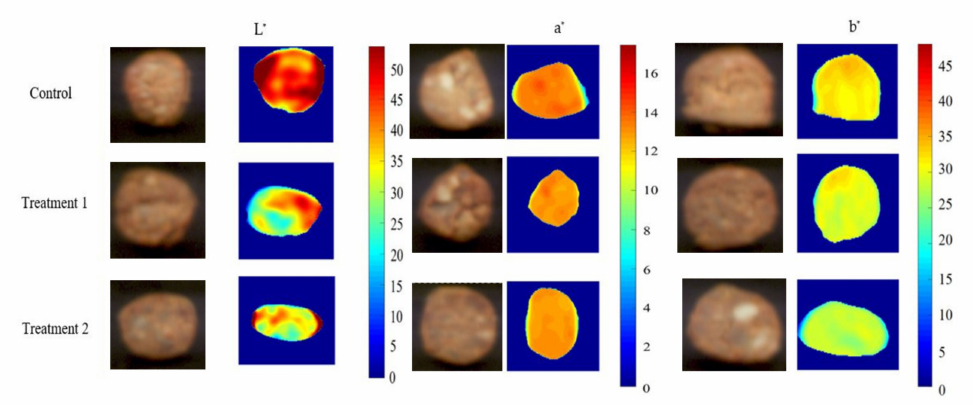
Figure 3. Original sausage images and a corresponding distribution map of lightness (L*), redness (a*), and yellowness (b*) changes of control casing sausages (up), and sausages stu ff ed in modified casings using treatment 1 (central) and treatment 2 (down) kept at 4 ◦ C after one day